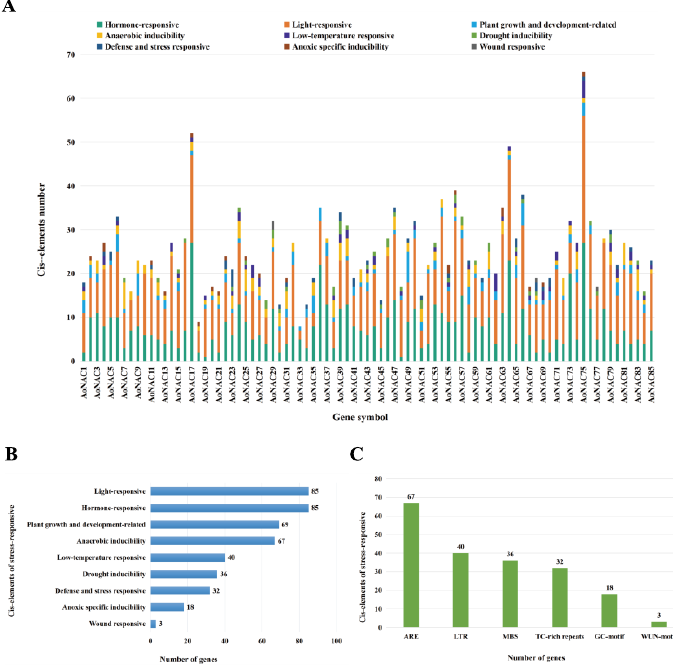
Figure 4. The cis-acting elements analysis of AoNAC genes. ( A ) Based on the promoter 2000 bp sequences of 85 AoNAC genes, we analyzed the light-responsive, hormone-responsive, plant-growth- and-development-related, anaerobic inducibility, low-temperature responsive, drought